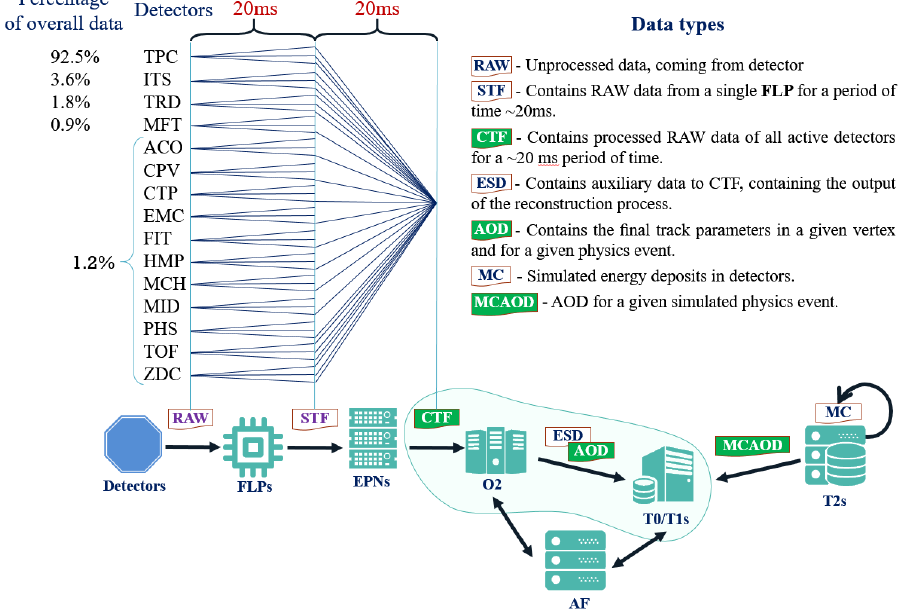
Fig. 1. Data flow in the ALICE Computing Model for Run 3 and Run